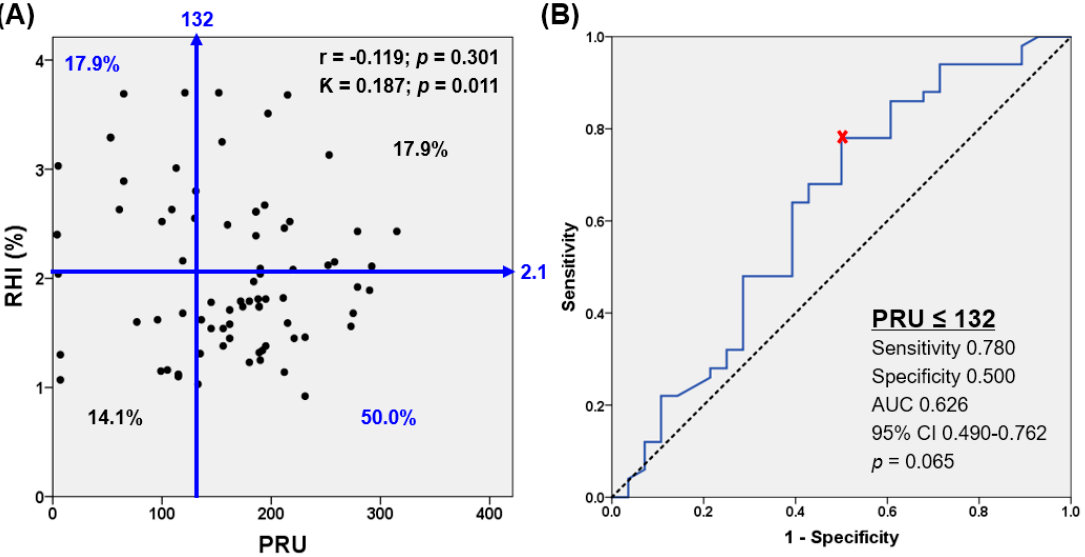
Figure 3. Relation between platelet reactivity and RHI ( A ) and ROC curve analysis for platelet reactivity corresponding to normal endothelial function (RHI ≥ 2.1) ( B ). AUC, area under curve; CI, confidence interval; ROC, receiver operating characteristic.